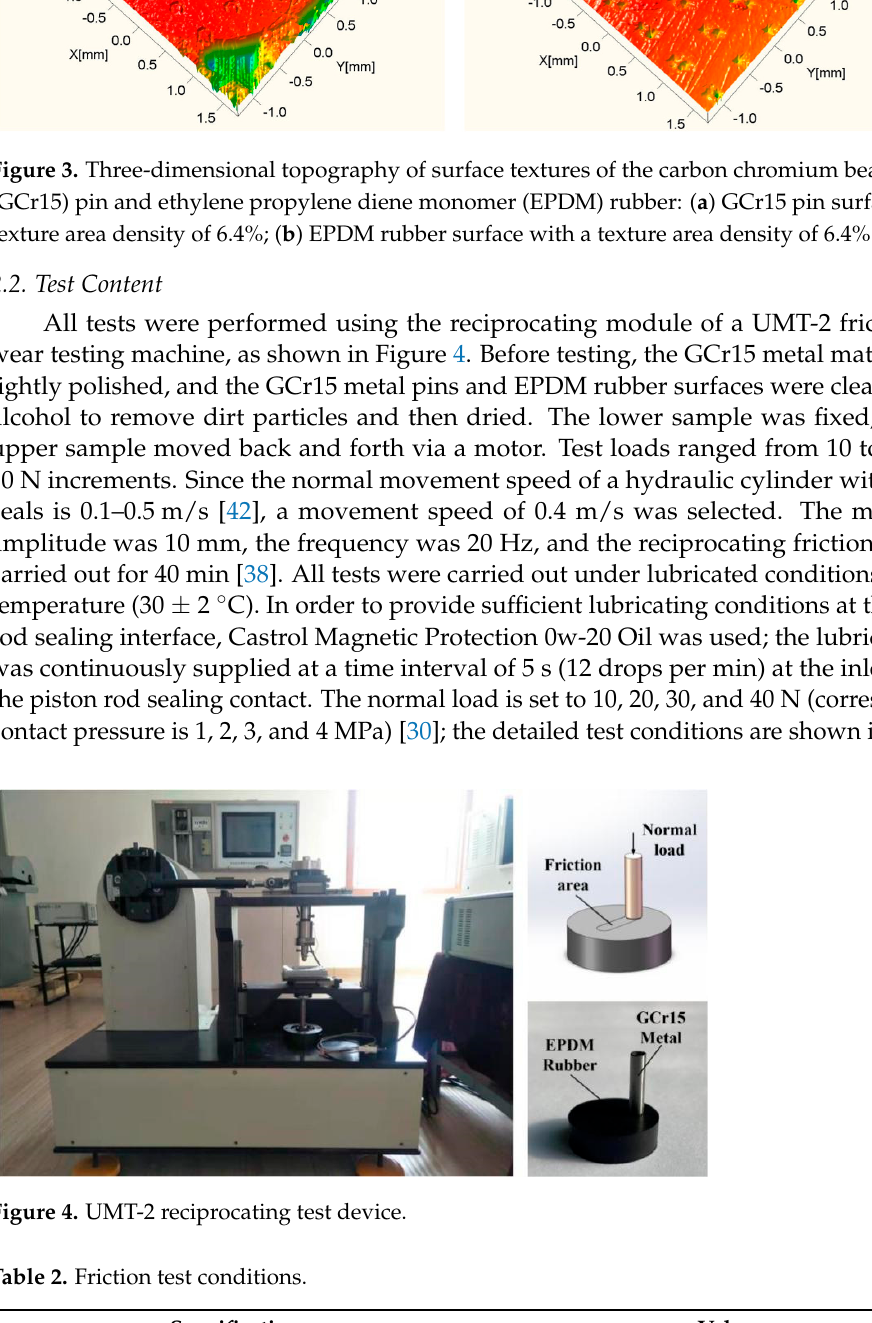
Figure 3. Three-dimensional topography of surface textures of the carbon chromium bearing steel